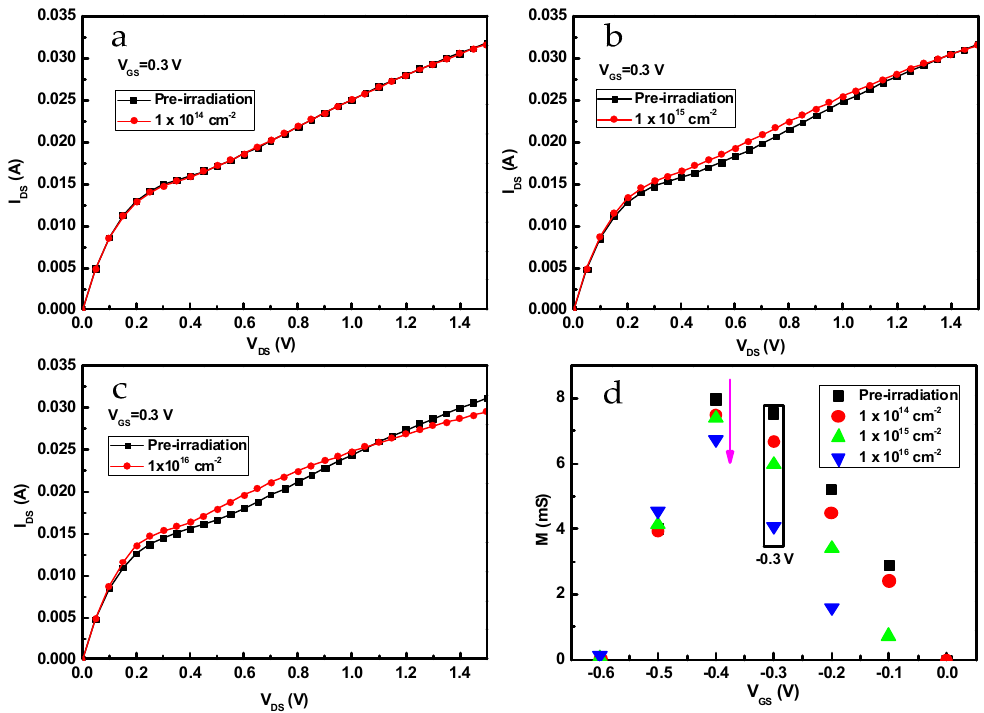
Figure 3. Output characteristics of InP-based HEMTs before and after 1 MeV electron irradiation with V GS = − 0.3 V. ( a ) 1 × 10 14 cm − 2 , ( b ) 1 × 10 15 cm − 2 , ( c ) 1 × 10 16 cm − 2 , ( d ) M impact factor.